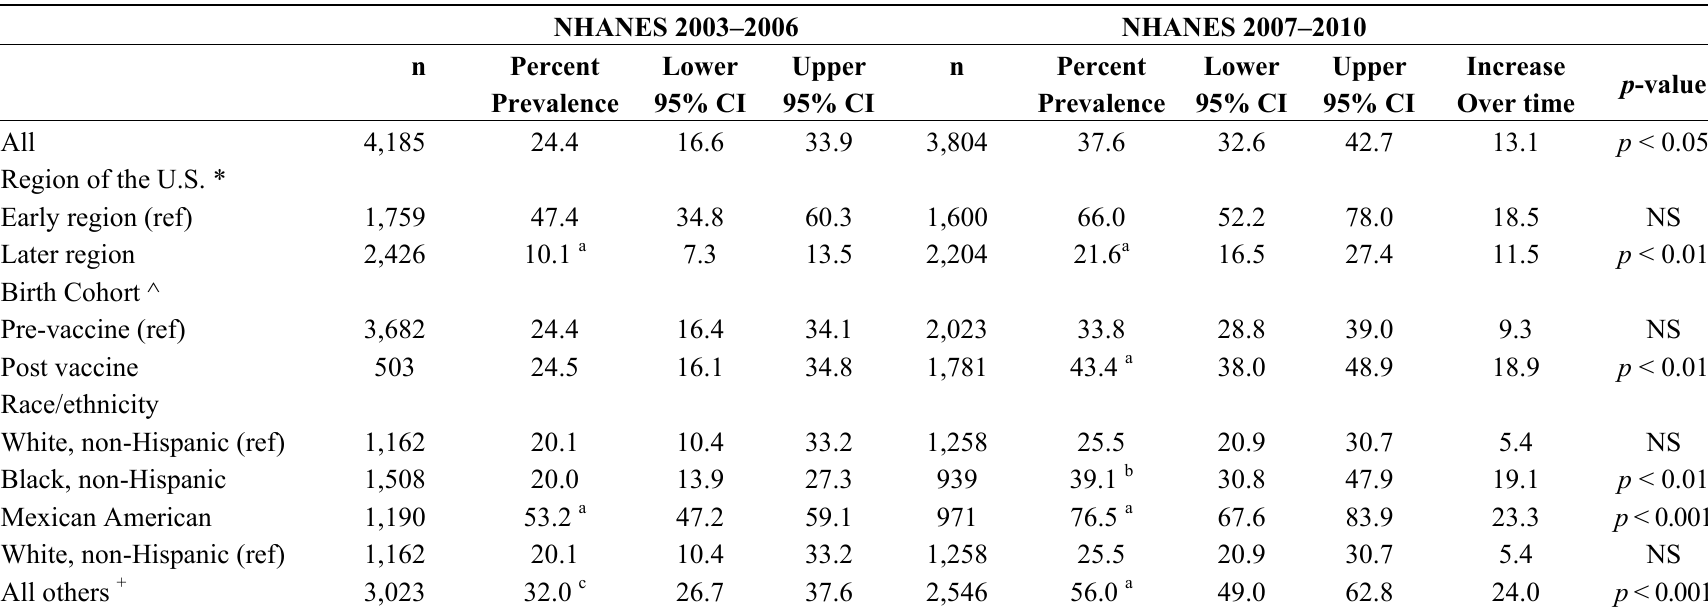
Table 1. Prevalence of HAV antibody among U.S. born 6–19 year old children and adolescents: NHANES 2003–2006 and